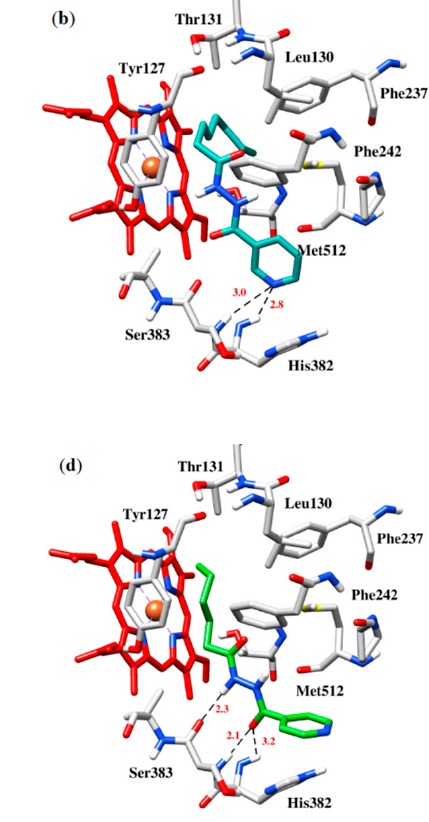
Figure 10. Binding poses of 5 – 7 and 10 are depicted in panels ( a – d ) in alphabetical order and amino acid residues of antifungal target protein CYP51 (light grey) from Candida glabrata . The dashed black lines depict hydrogen bond interaction.